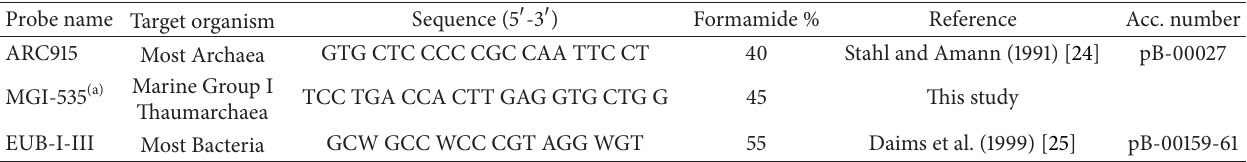
Table 1: CARD-FISH probes used for the analysis of prokaryotic community composition at 200 and 350 m depth in Lake Maggiore. For each probe, short name, target organisms, sequence, formamide concentration (formamide %), references, and probe accession number on probeBase are indicated. (a) Probe MGI-535 was specifically designed for this study, targeting Marine Group I (MGI)